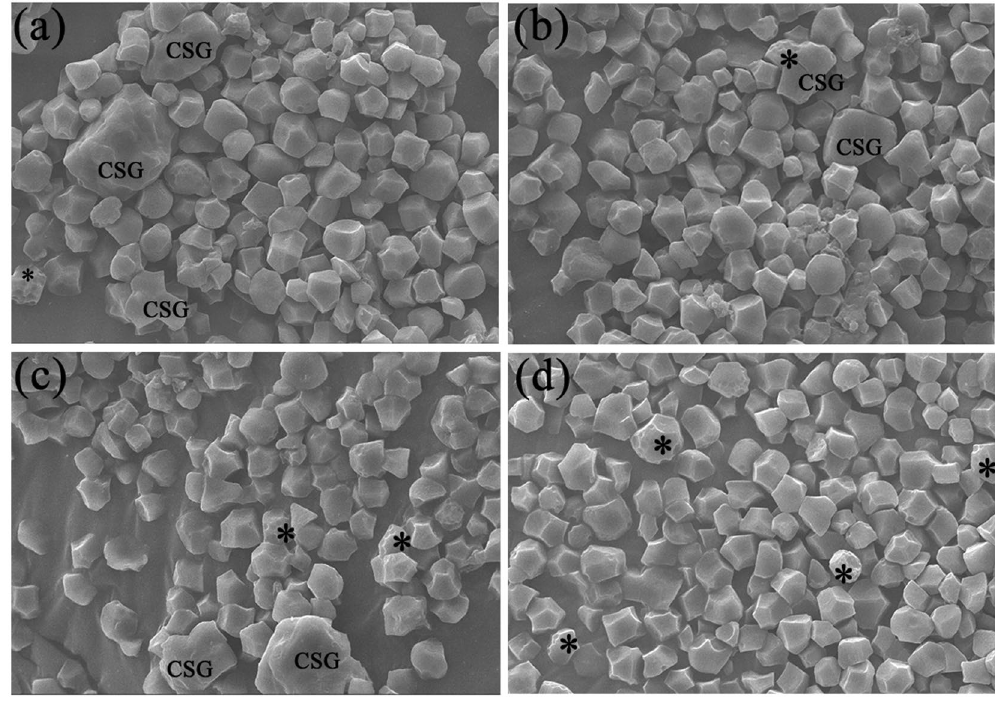
Figure 6. SEM micrographs of starch granules of unprimed seeds ( a ), AgNO 3 -primed seeds ( b ), hydroprimed seeds ( c ), and AgNPs-primed seeds ( d ). Starch granules were isolated from seeds after 24 h of imbibition. Asterisk indicates starch granule with small pits. CSGs, compound starch granules. (Scale bar = 20 µ